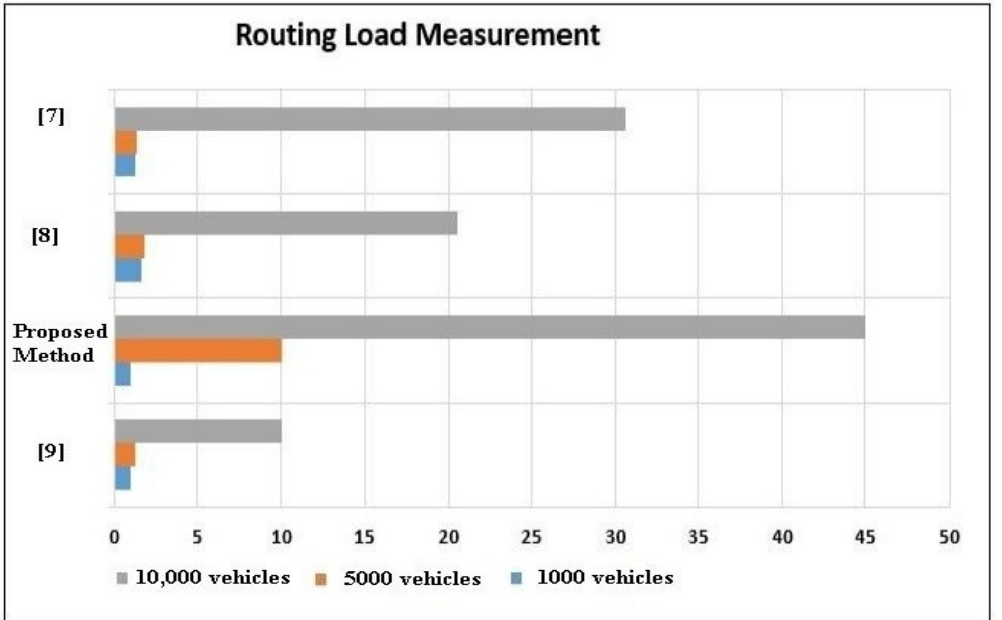
Figure 3. Routing load measurement (RLM).